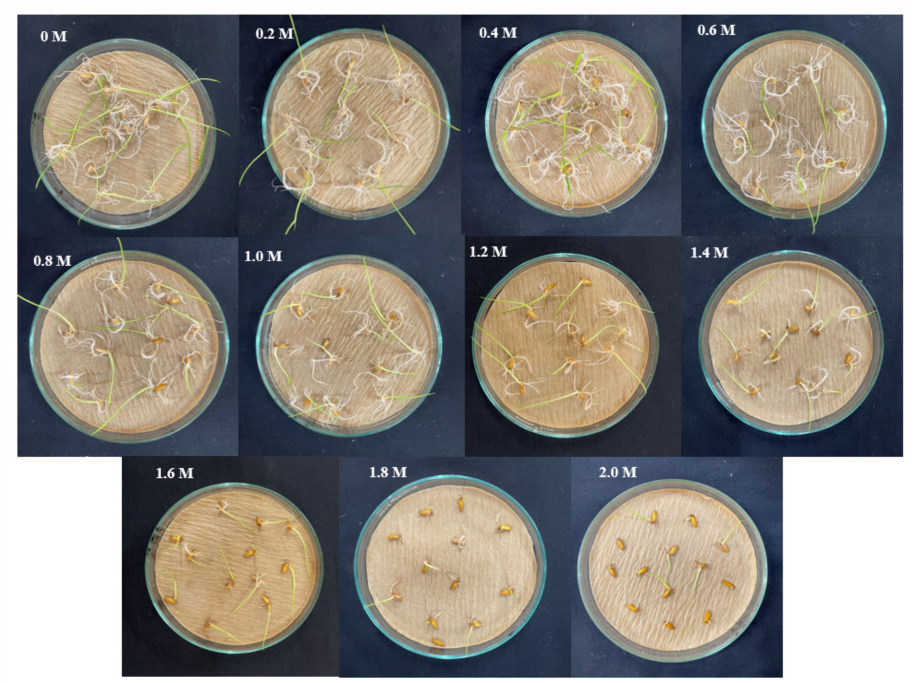
Figure 6. Optimization of sodic stress induction in selected cultivars. The concentration indicates the mole of sodium.